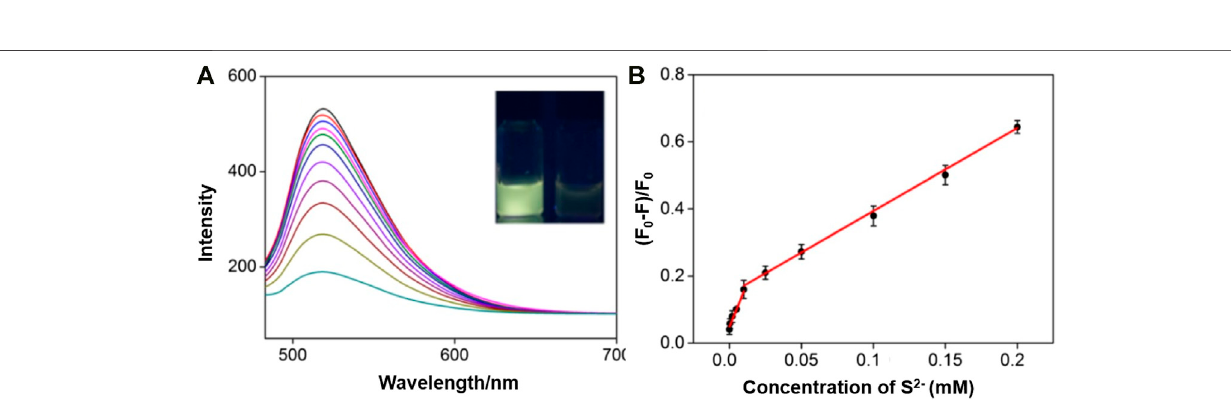
FIGURE6|(A) FLemissionspectraofIL-GQDsinthepresenceofdifferentconcentrationsofS 2 − ion.InsetimagespresentthephotographsofIL-GQDssolutionsinthe absence (left) or absence (right) of S 2 − ion under 365nm UV light. (B) Linear relation curve between fl uorescent quenching ratio and the concentration of sul fi de ion.